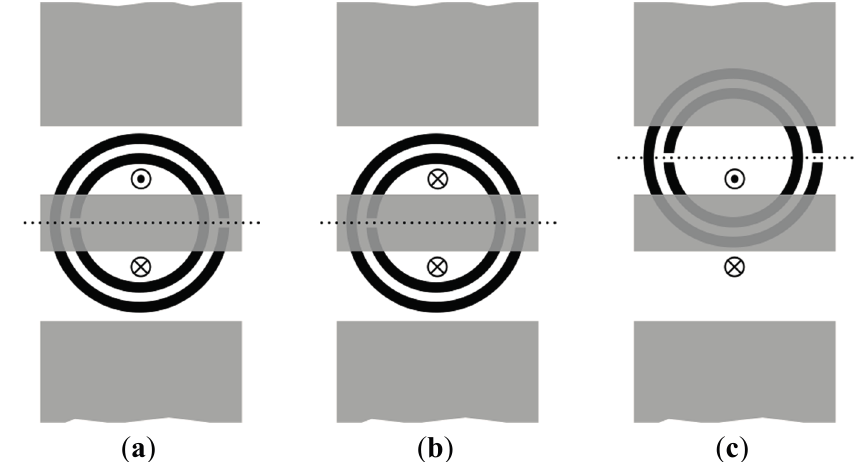
Figure 2. CPW transmission line loaded with a single SRR. ( a ) Line and resonator aligned and excitation with the fundamental (even) mode; ( b ) line and resonator aligned and excitation with the slot (odd) mode; ( c ) line and resonator misaligned and excitation with the fundamental (even) mode. The cross and dot point to the direction of the magnetic field axial to the